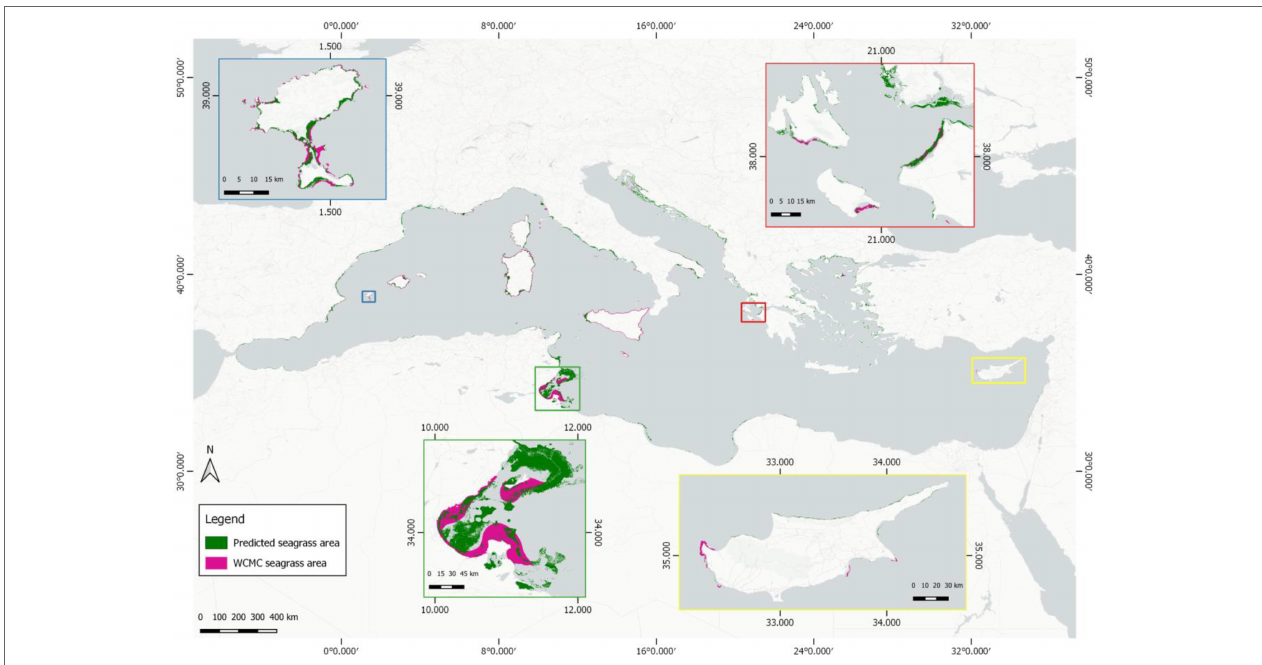
FIGURE 5 | Pan-Mediterranean P. oceanica seagrass extent (this paper: green, pink ( Telesca et al., 2015 )). The four inset panels depict the two estimates of mapped seagrass extent in Ibiza and Formentera, Spain (blue inset), Gulf of Gabes, Tunisia (green inset), NW Peloponnese and South Ionian Sea, Greece (red inset), and the country scale of Cyprus (yellow inset).